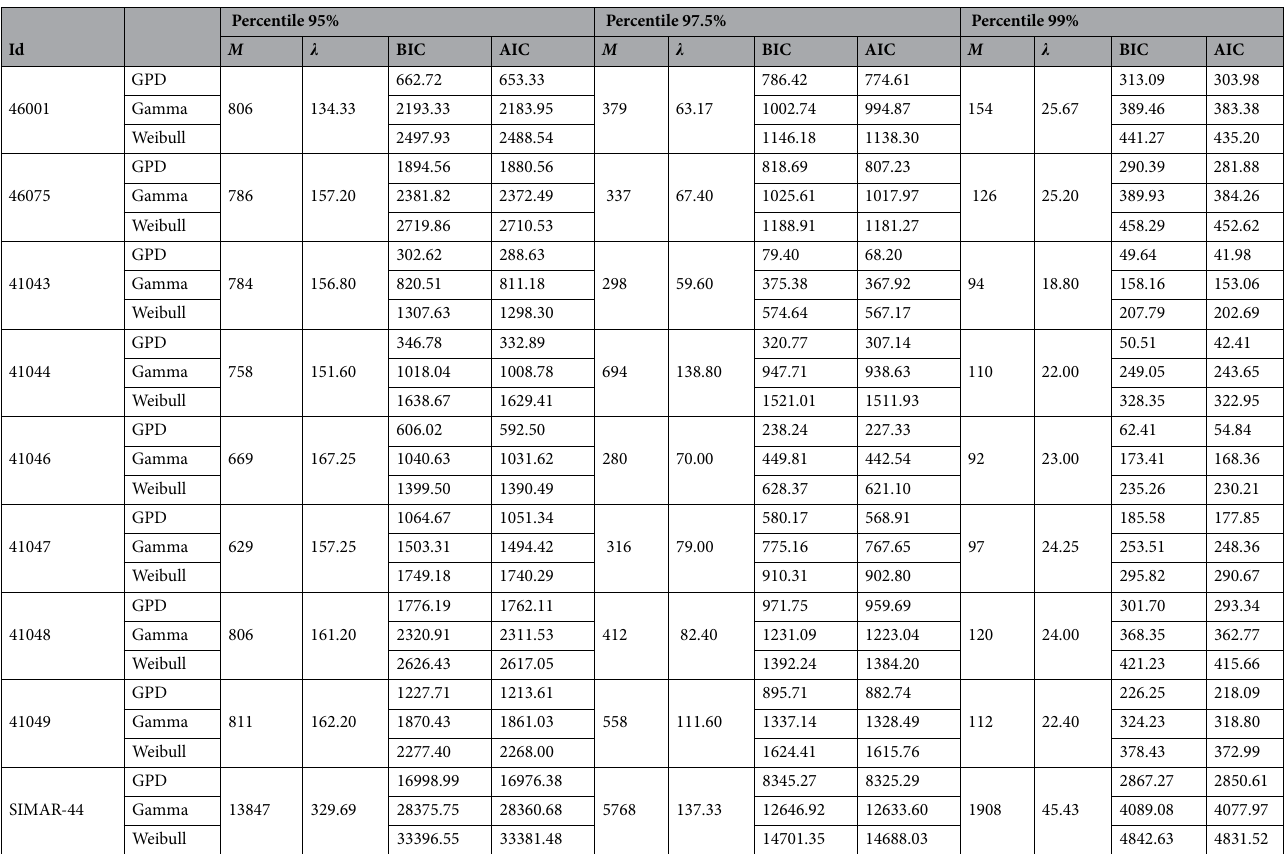
Table 3. BIC and AIC criterion for the estimated distributions of the POT